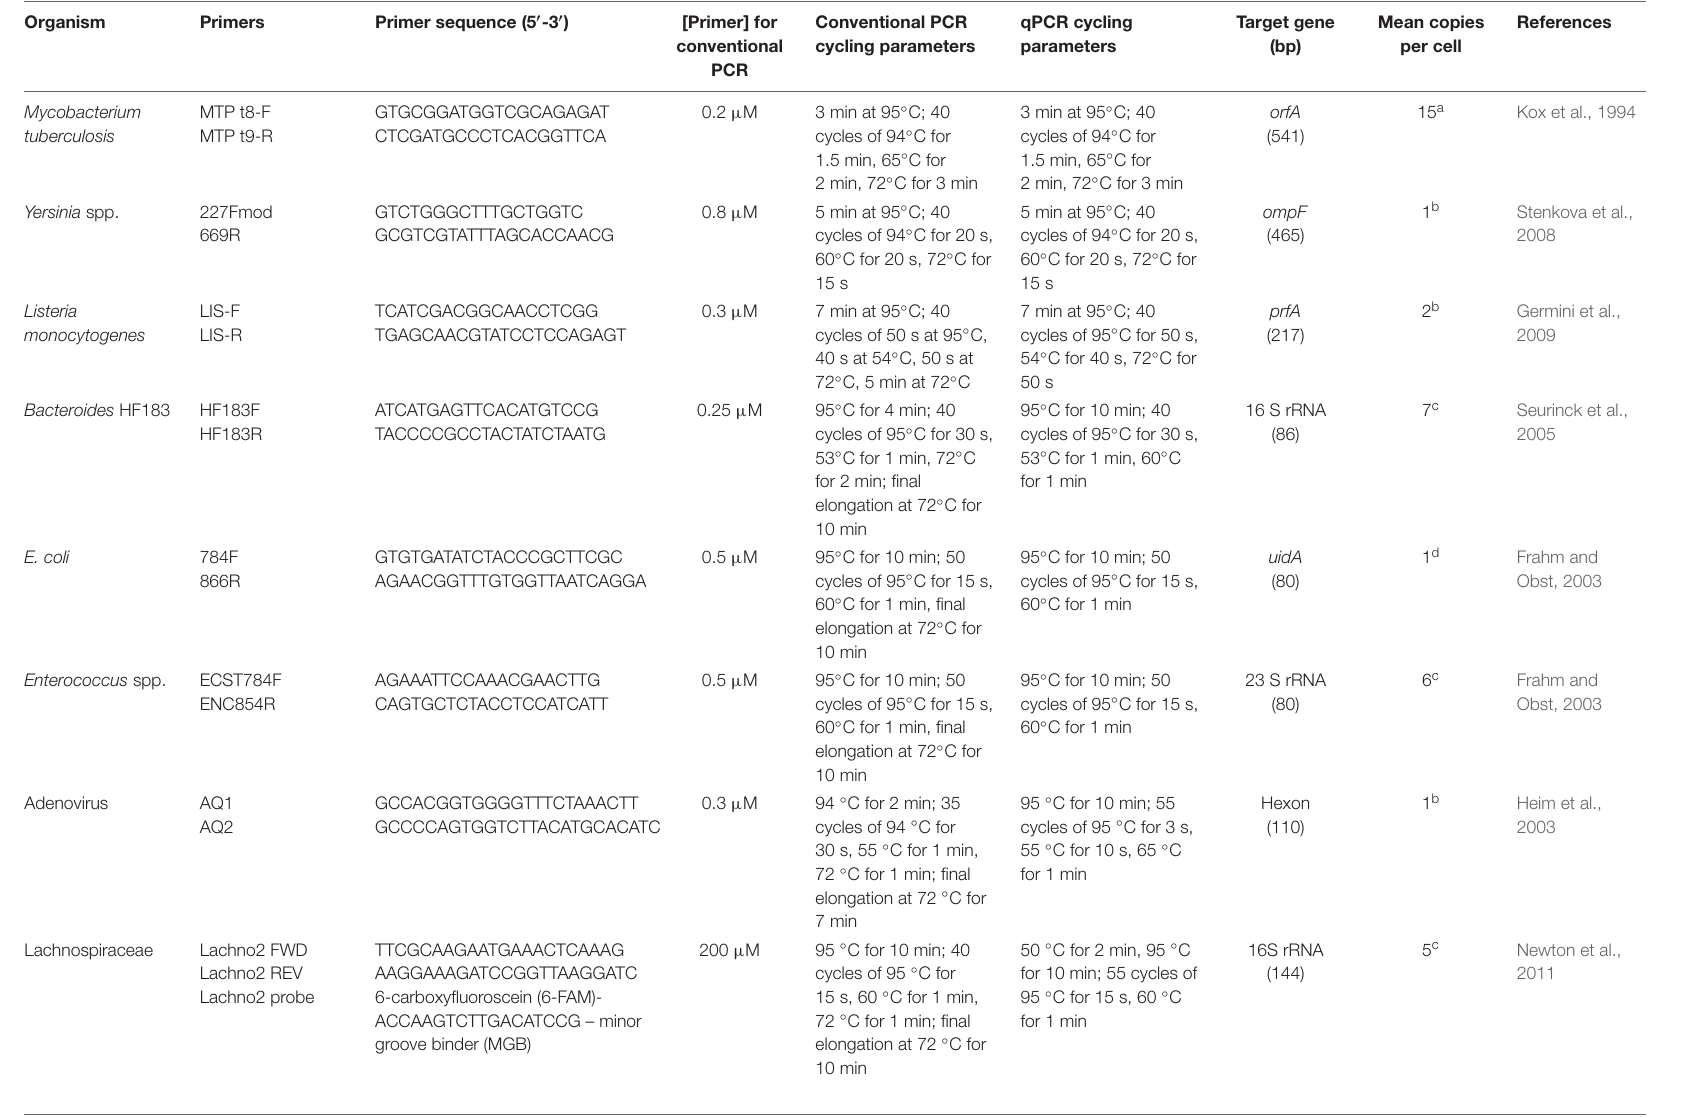
TABLE 1 | Conventional PCR and qPCR primers, cycling parameters and PCR product size of the organisms screened for in the RHRW samples.